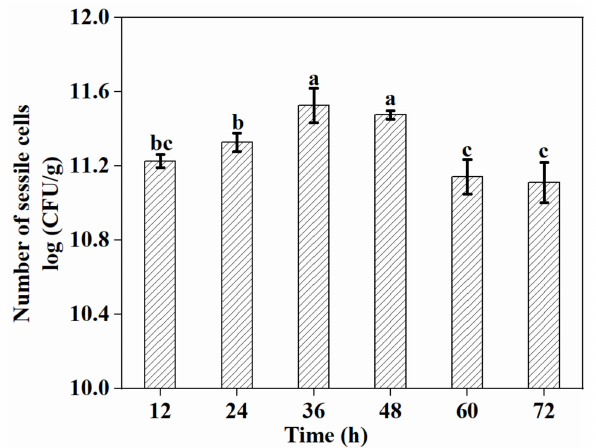
Figure 4. Impact of culture time on the number of sessile cells. Significant differences ( p < 0.05) are indicated by different letters (a, b, and